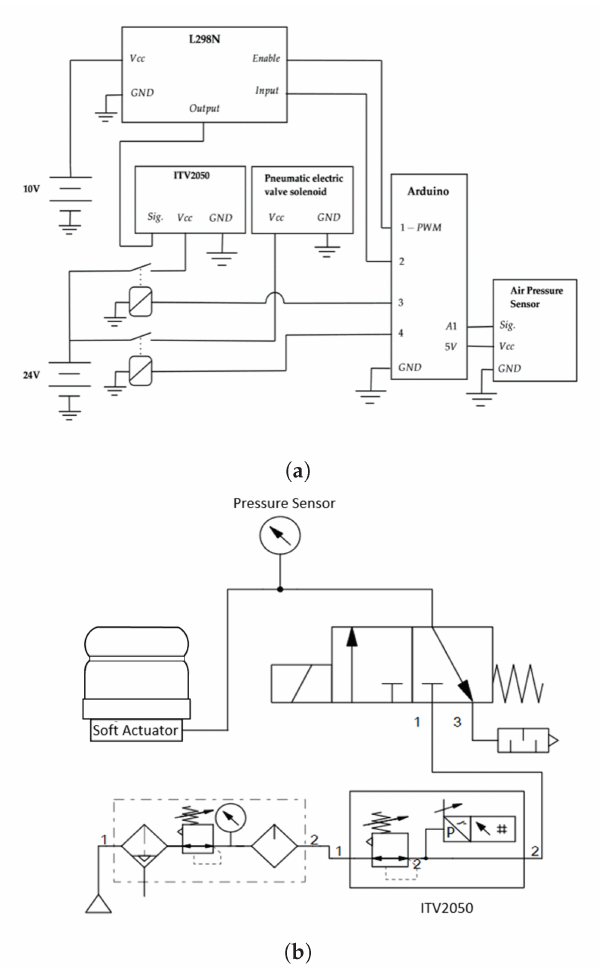
Figure 10. Electric and pneumatic systems. ( a ) Electric scheme of the modular soft grippers. ( b ) Pneu- matic